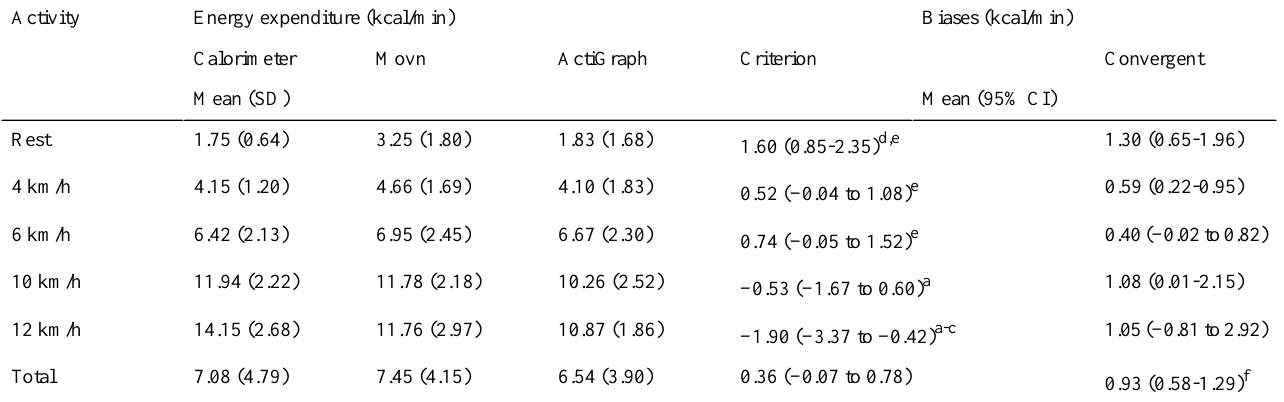
Biases (kcal/min)Energy expenditure (kcal/min)Activity